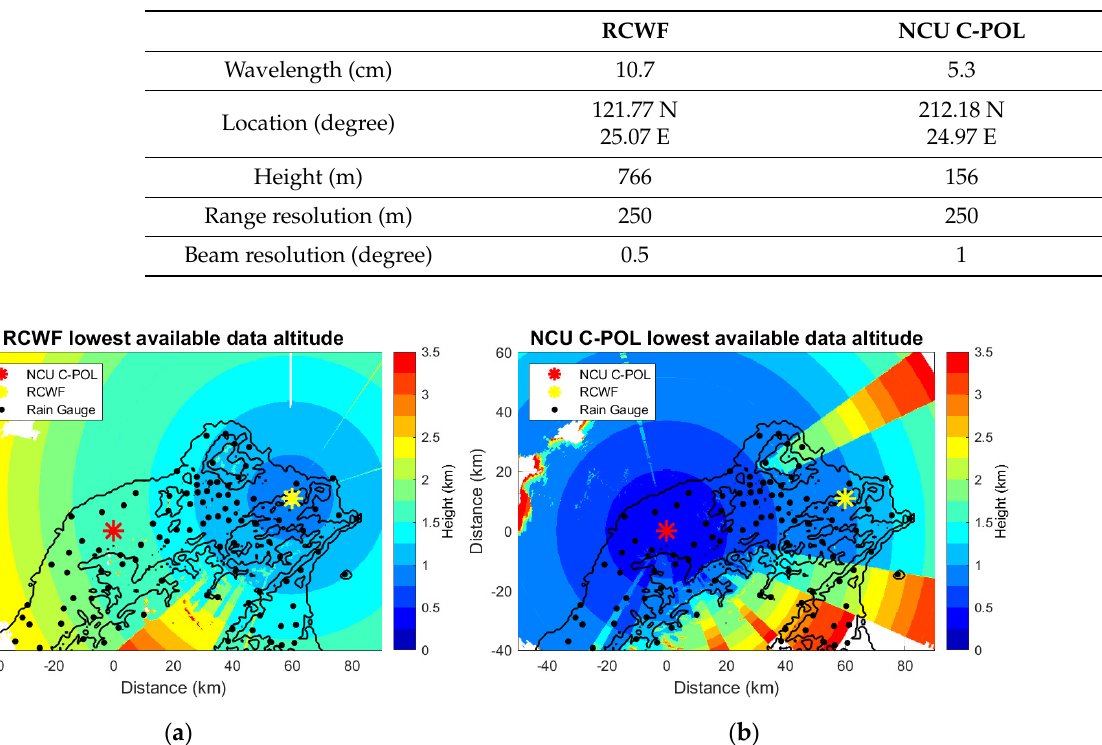
Table 1. The basic information for RCWF (radar code of Wu-Fanshan, NEXRAD WSR-88D S-band dual-pol radar, Ryzhkov et al. [9] from the Central Weather Bureau (CWB) and NCU C-POL) National Central University C-band polarimetric radar).